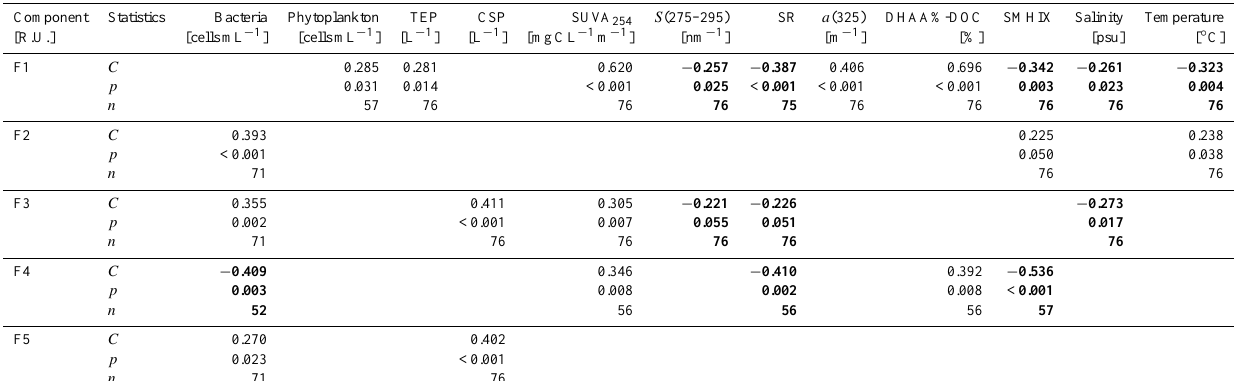
Table 4. Spearman rank order correlation coefficients ( C) between fluorescent components (F1–5) and total bacterial and phytoplankton cells, TEP and CSP particles, SUVA 254 , S (275–295), SR, a (325), DHAA%-DOC, SMHIX, salinity and temperature measured in our study, both in the SML and ULW. Statistical significance was accepted for p <0.05. n = number of samples. Only statistically significant correlations are shown. Bold characters indicate negative correlations.